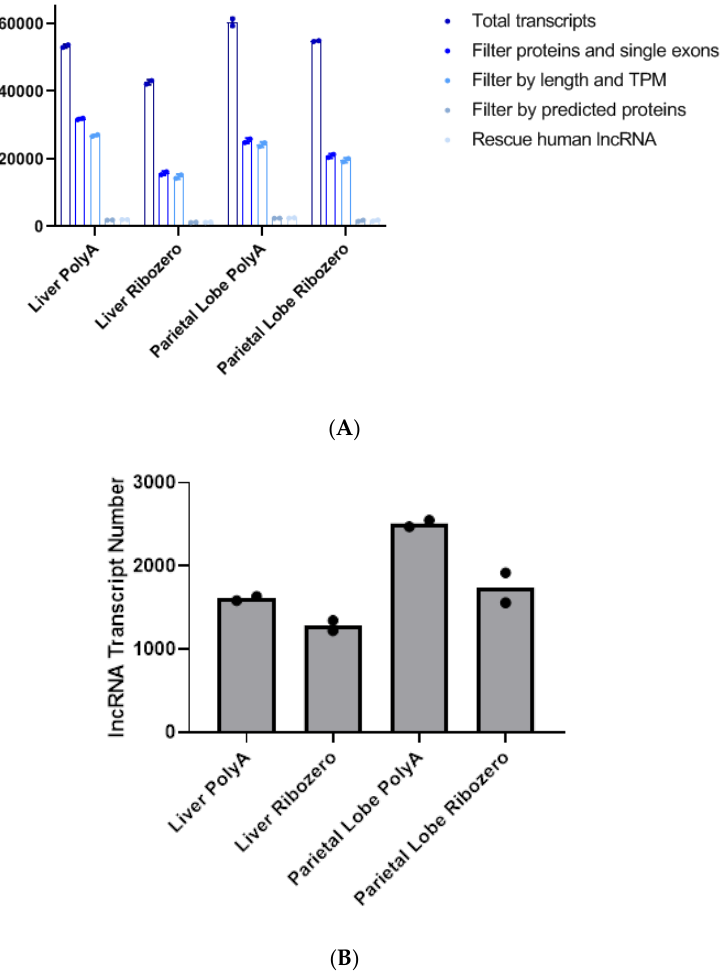
Figure 1. ( A ) Bar graph showing the average number of total transcripts between the two horses after each filtering step. TPM = transcripts per million. ( B ) Number of unique long non-coding RNAs (lncRNA) in each tissue library preparation combination (same as the last bar in A). Each data point represents one horse. PolyA indicates poly-A + selection.